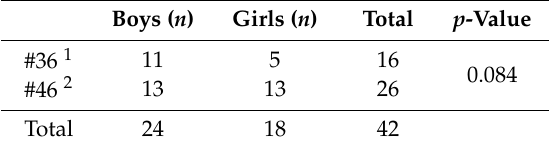
Table 2. Distribution of impacted molars with respect to gender.